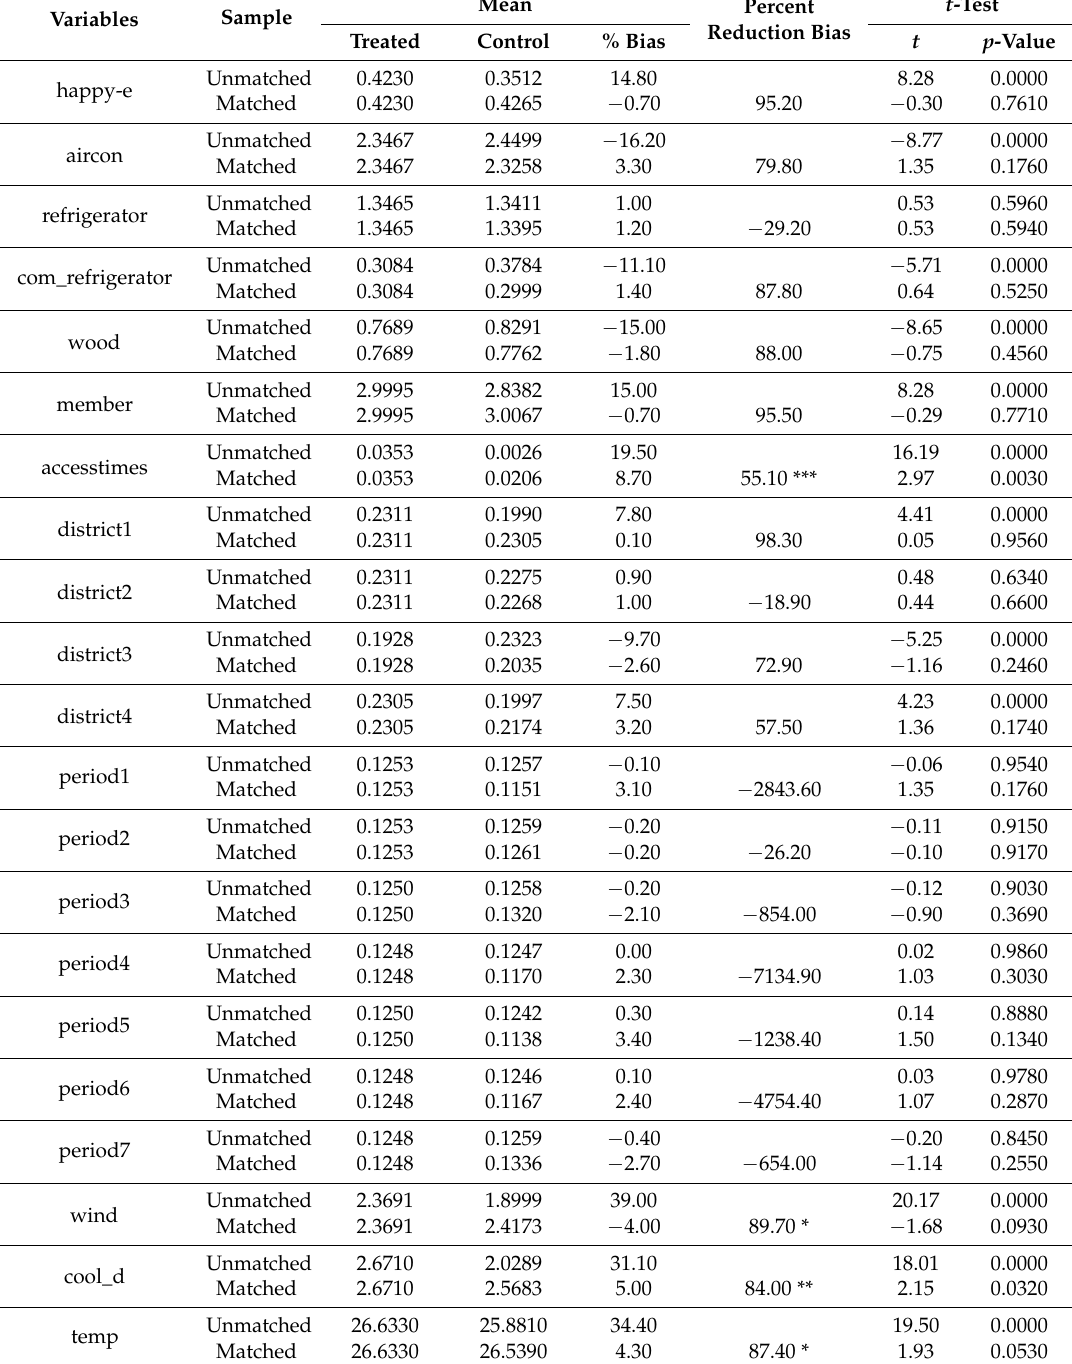
Table A4. Result of balancing test of propensity score model of Dum_80_elas